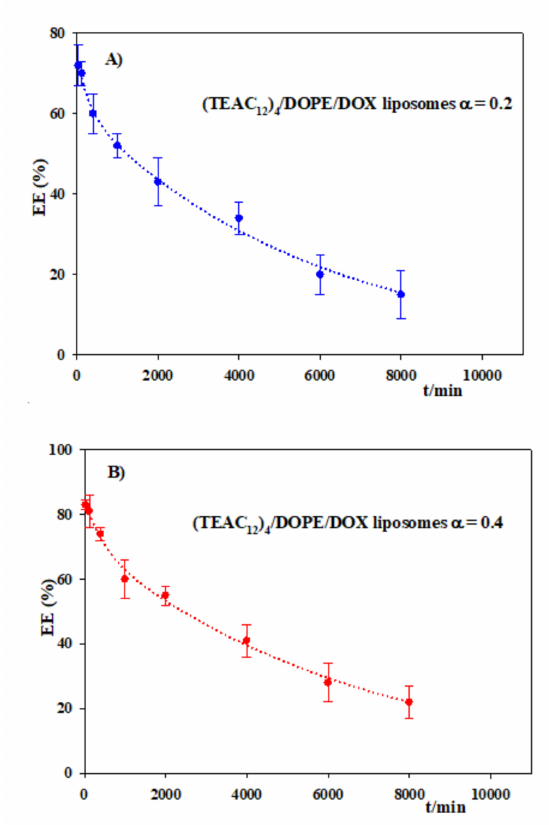
Figure 13. Release of doxorubicin from DOX loaded (TEAC 12 ) 4 /DOPE liposomes at 310 K. ( A ) α = 0.2; ( B ) α = 0.4. The values are the average of three independent